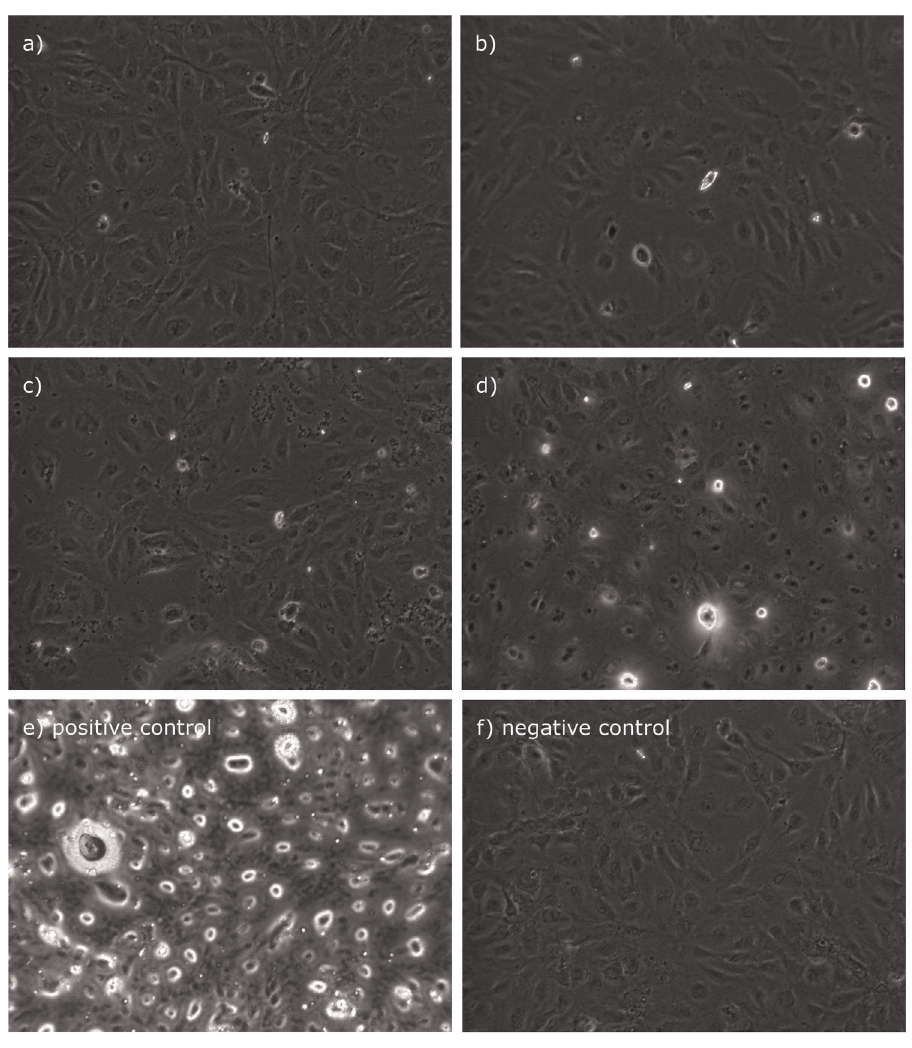
Figure 5. TUNEL Fluorescence Microscopy. Representative light microscopy images of TUNEL fluorescence in labeled AC-HUVECs after 24 hours of hypoxia, 2 hours of isoflurane exposure with 0 MAC (control; fig. 4a), 0.5 MAC (b), 1 MAC (c), 2 MAC (d), and a subsequent 24-hour recovery. In addition, positive (e) and negative (f) controls are presented.